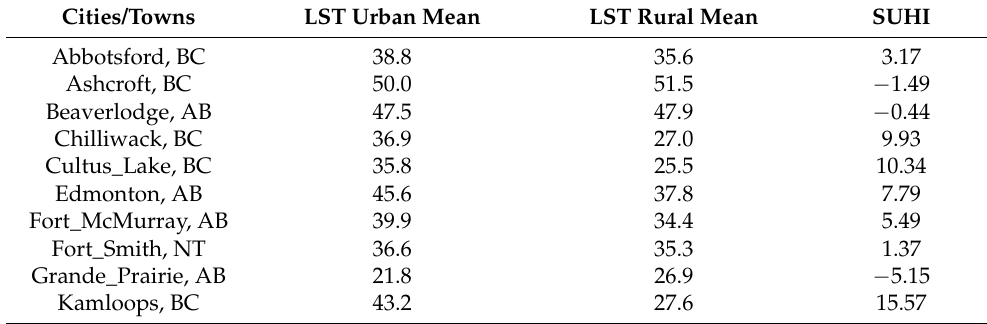
Figure 3. MODIS true color composite maps (left column, 500 m) and MODIS SUHI intensity (central and right column 1 km): a. daytime and b. nighttime over Lewiston, Vancouver, Edmonton, and Fort McMurray cities for the 26 June 2021. Table 4. Landsat-8 data for the sample of 18 cities: urban LSTs, rural LSTs, and SUHI intensity. Cities/Towns